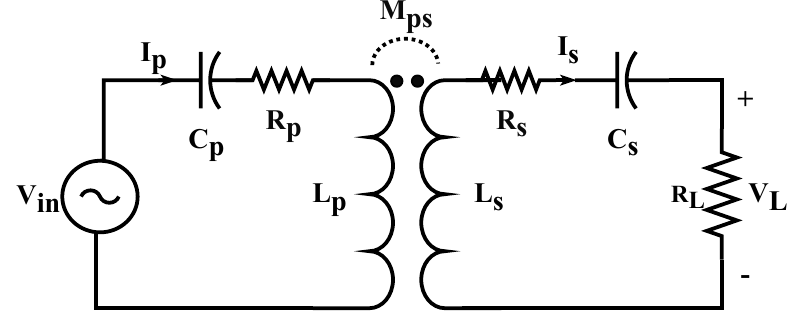
Figure 3. Schematic of a S-S compensation network connected to the primary and secondary